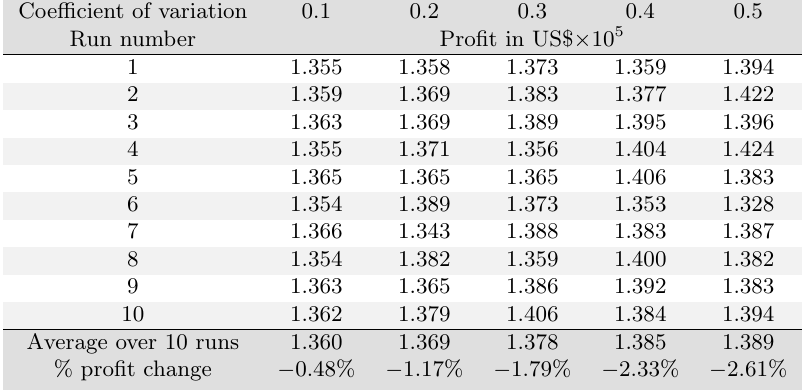
Table 8: Profit from random catch and variable trawler schedule for IFPML. Coefficient of variation